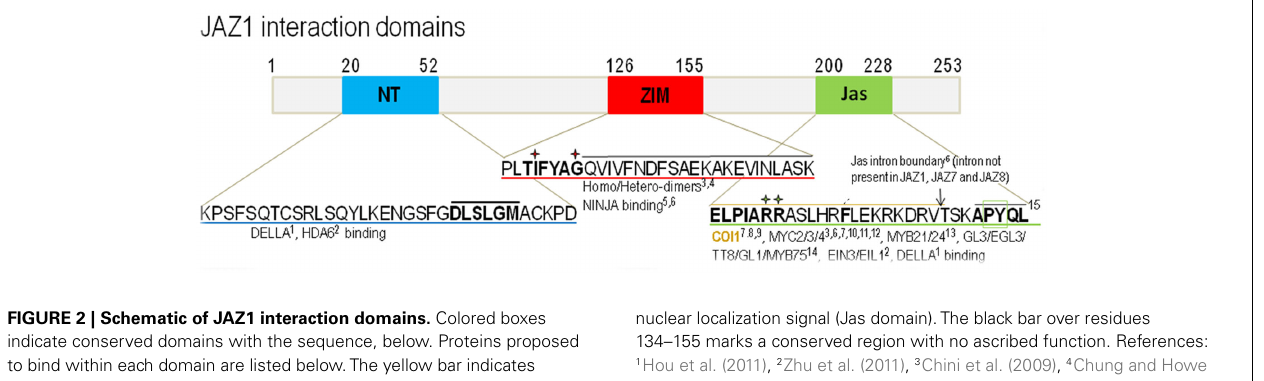
FIGURE 2 | Schematic of JAZ1 interaction domains. Colored boxes indicate conserved domains with the sequence, below. Proteins proposed to bind within each domain are listed below.The yellow bar indicates residues sufficient for COI1 binding. Red stars mark residues required for forming homo- and/or heterodimers (ZIM domain). Green stars mark residues required for COI1 binding (Jas domain).The black bars over bold residues mark a conserved EAR-like motif (NT domain) and a proposed